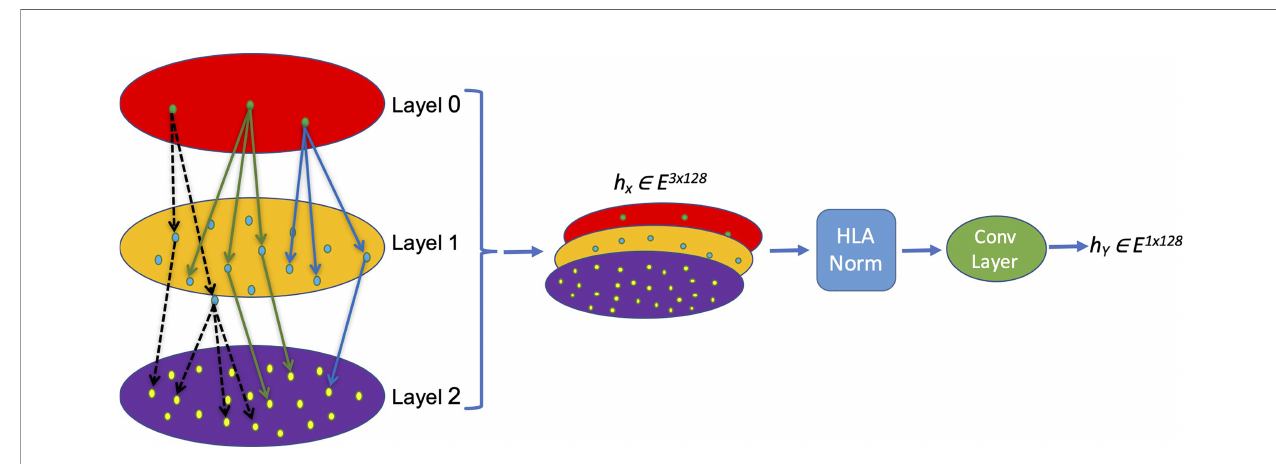
FIGURE 1 | Schema of the MHC-II subtype hierarchical relationship encoding. Each layer representing one fi eld of HLA name is converted into a [1×128] vector and concatenated into a [3×128] matrix, which is normalized and convoluted to get a [1×128] vector for